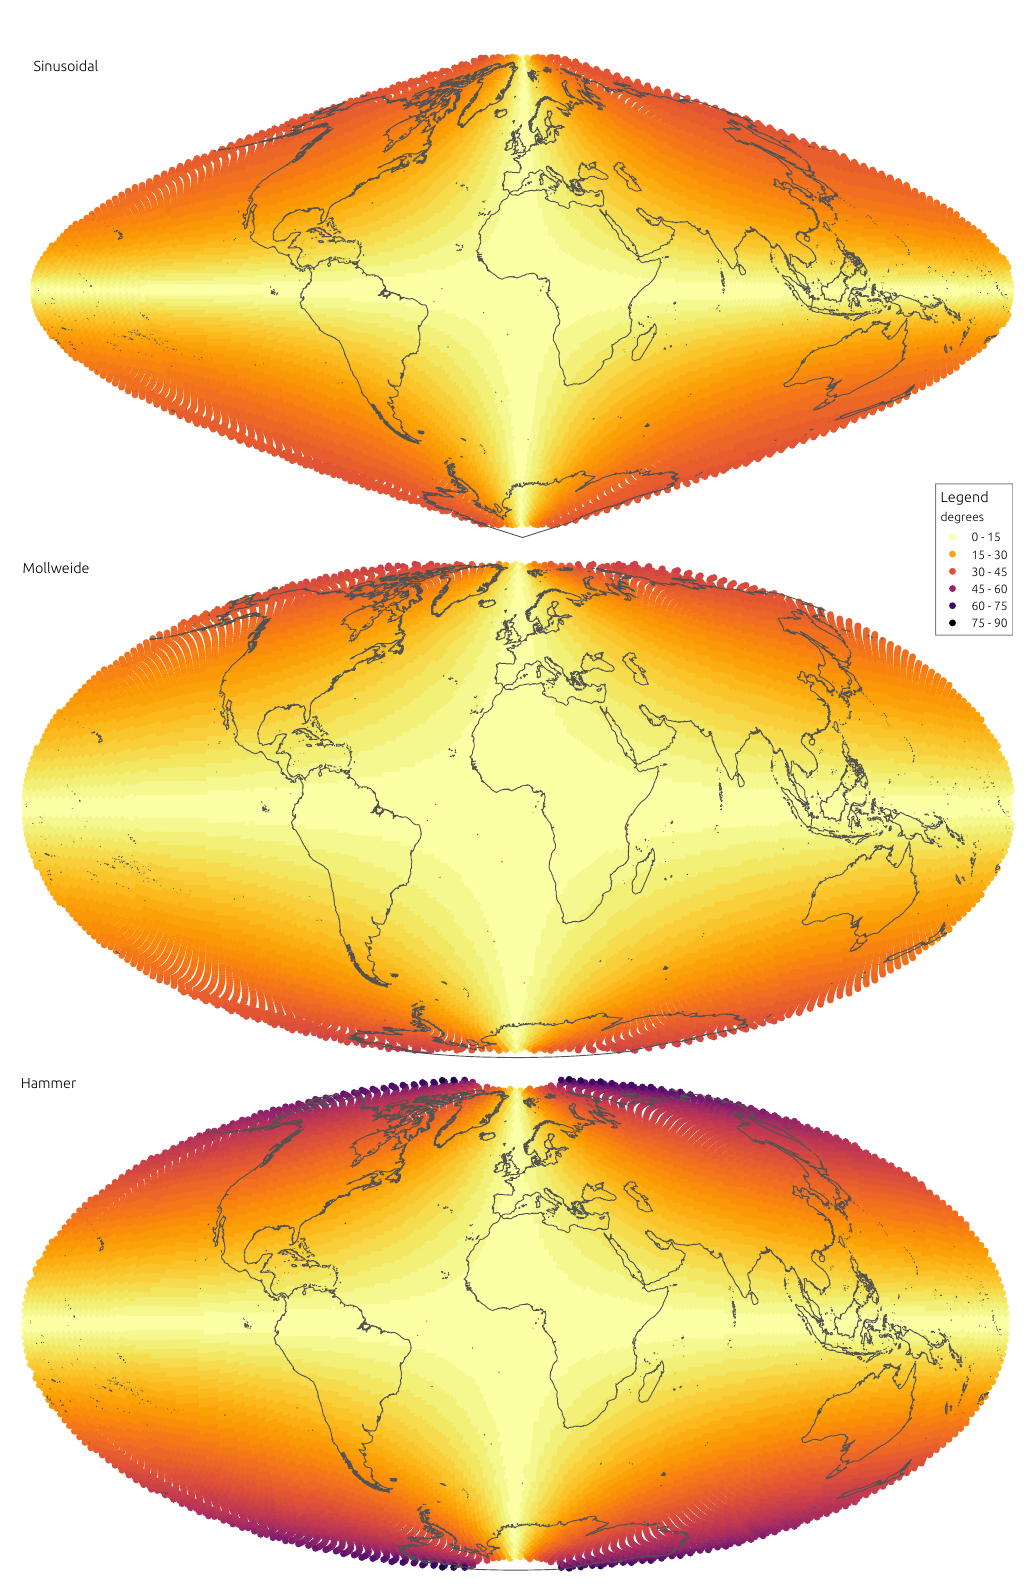
Figure 3. Mean absolute angular distortion at each indicatrix for the Sinusoidal, Mollweide and Hammer